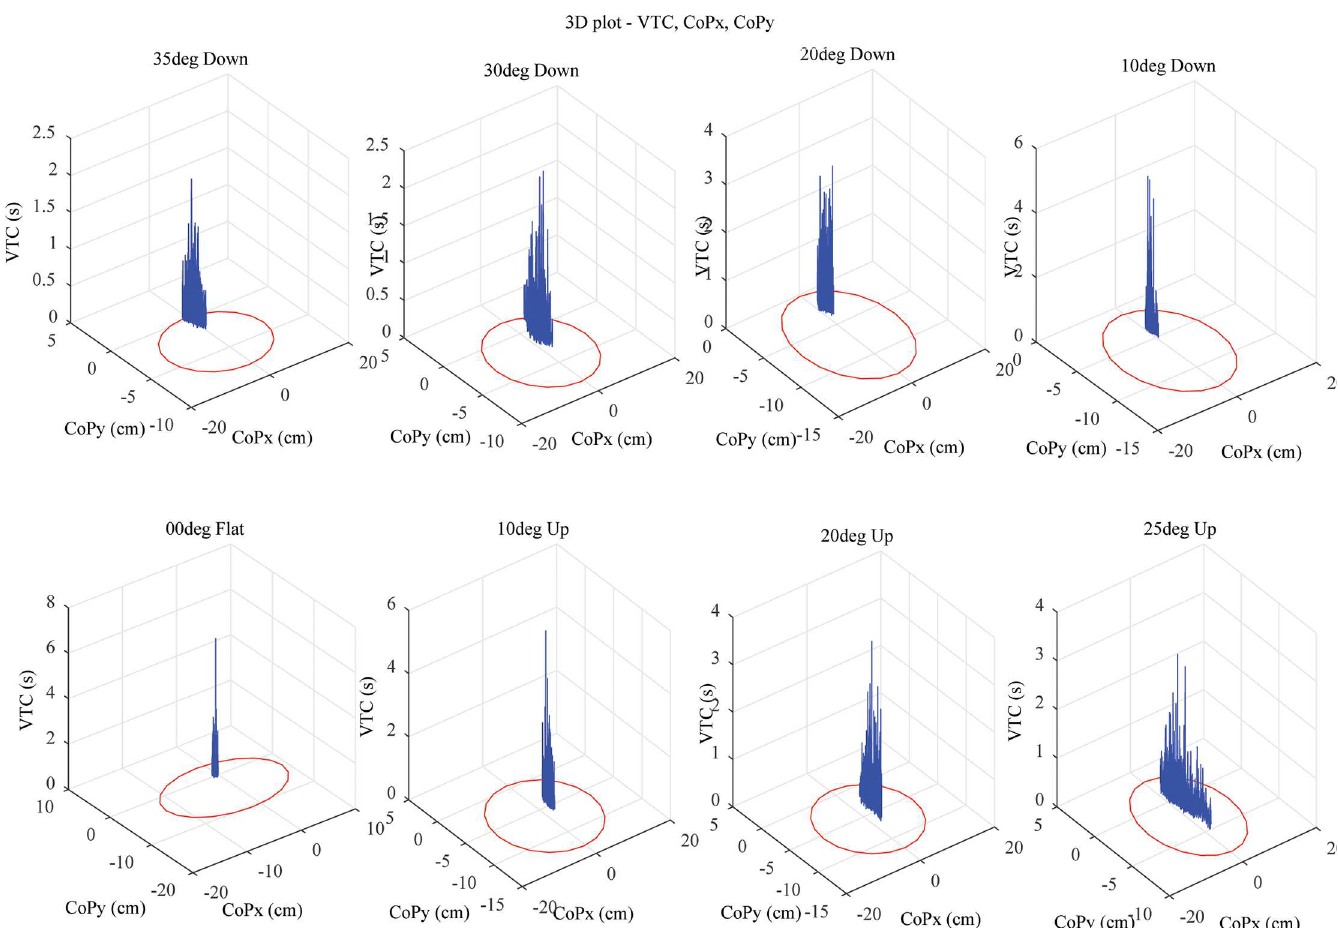
Fig 2. Representative 3D plot of VTC in CoPx and CoPy across all sloped platform conditions. The heel position is towards CoP y and the toes are oriented towards CoP x